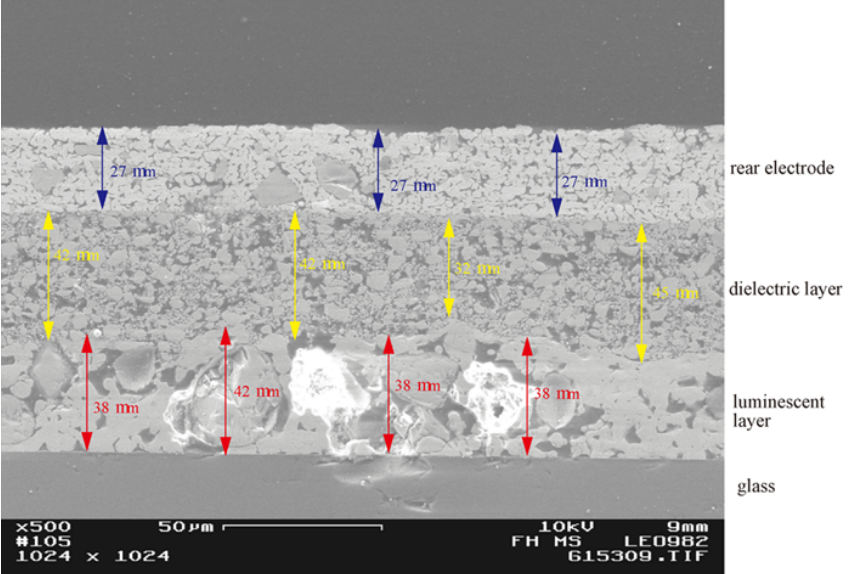
Figure 2 . Electron micrograph of a cross section through a printed thick-film AC-EL